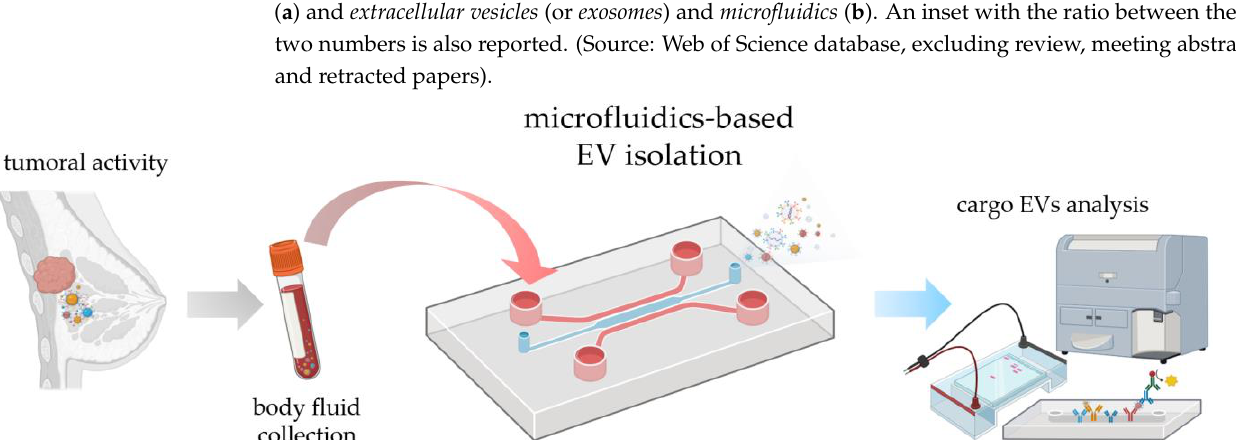
Figure 2. Possible workflow of tumor diagnosis using the microfluidic EV isolation strategy, from sample collection by liquid biopsy to analysis. The elements of the figure are created by BioRen- der.com.